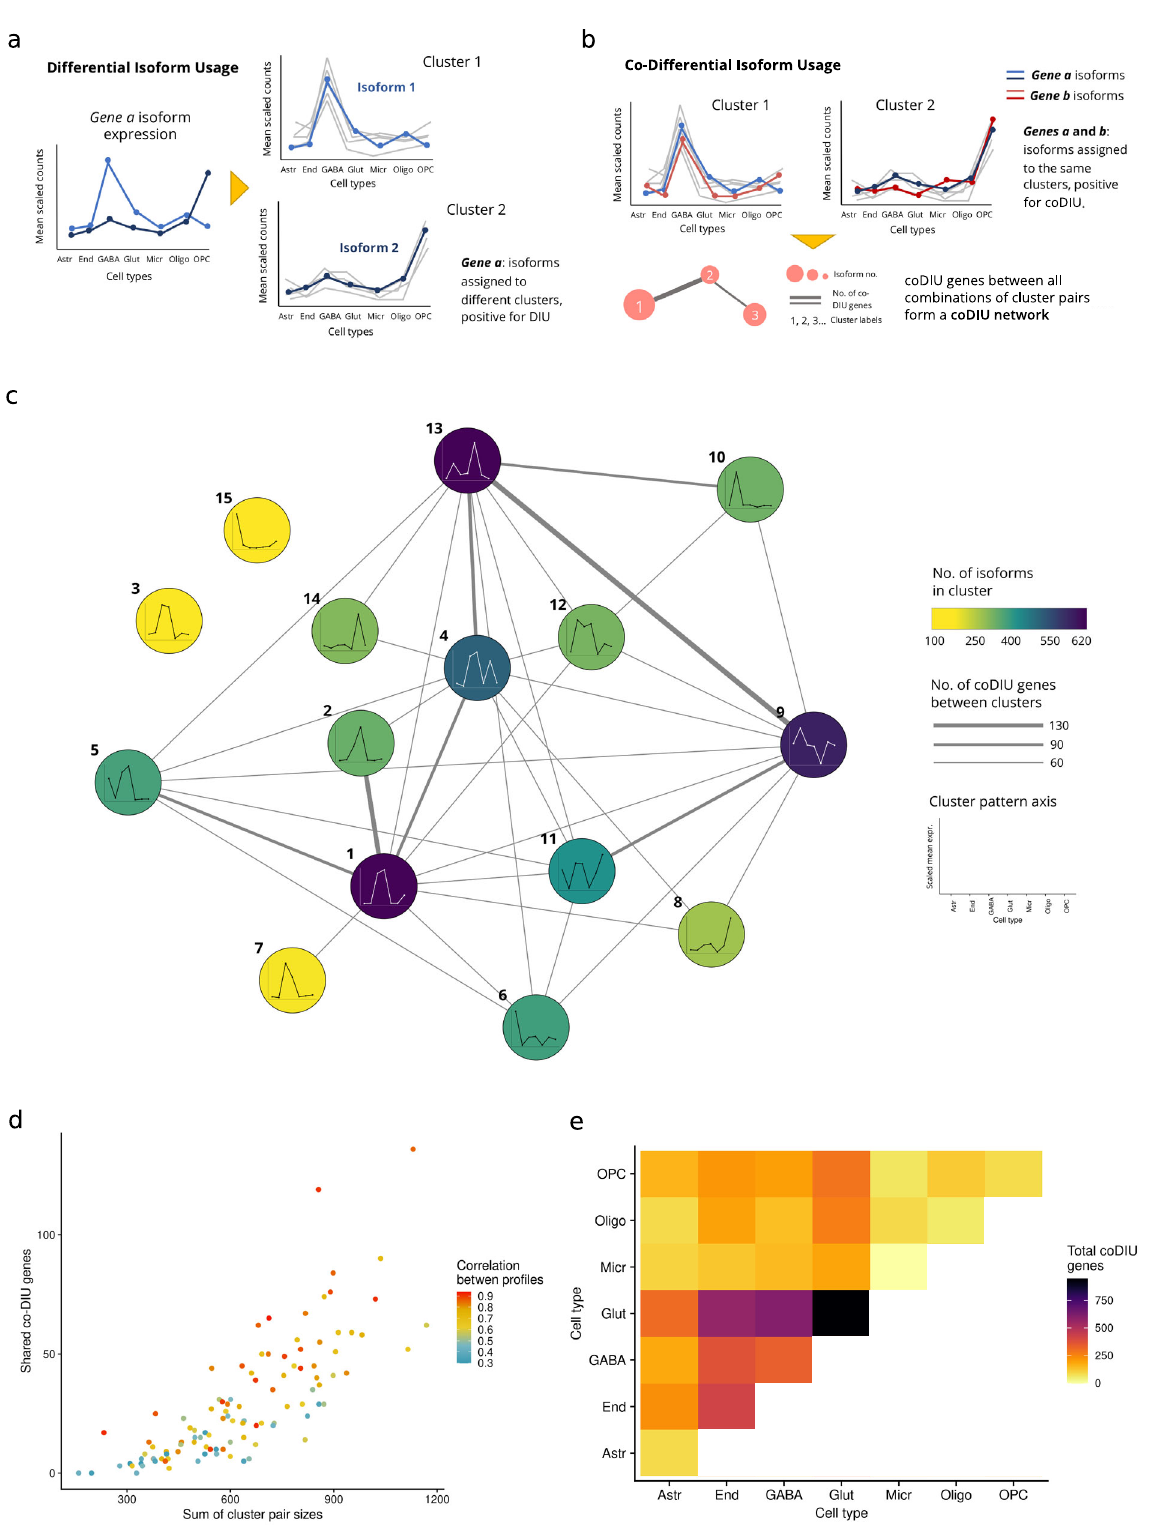
Co-Differential Isoform Usage analysis of single-cell isoform expression . Isoform clusters represent groups of alternative tran- scripts that are co-expressed at the cell type level. However, our clustering results did not provide information on iso-transcriptome properties associated with splicing regulation. To facilitate inter- pretation of the isoform clustering results, we fi rst de fi ned genes with DIU as those whose isoforms were assigned to different